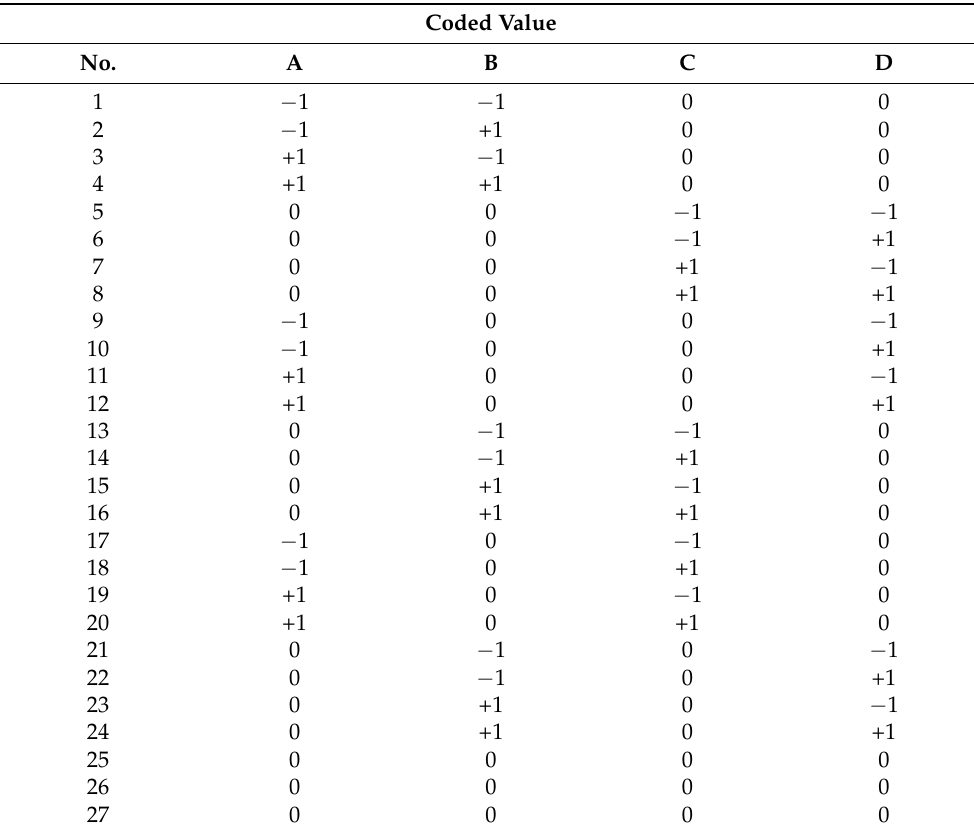
Table 2. Three-level matrix for four variables (A, B, C, and D) and three levels ( − 1, 0, and +1) according to BBD with resulting 27 single